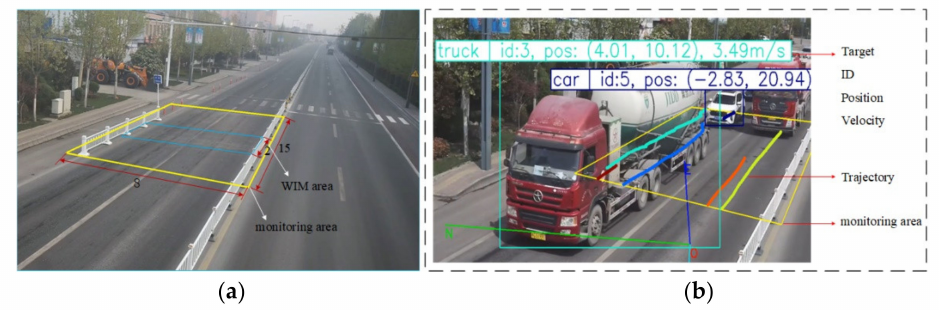
Figure 9. Vehicle tracking and status extraction results for weighing areas. ( a ) WIM monitoring area; ( b ) Vehicle driving status information